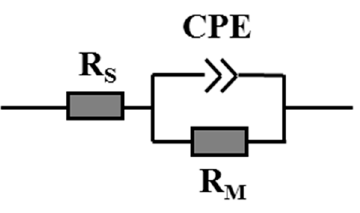
Figure 10. Bode plots of EIS analysis in terms of immersion time in 0.01 mol/L KCl solution: ( a )